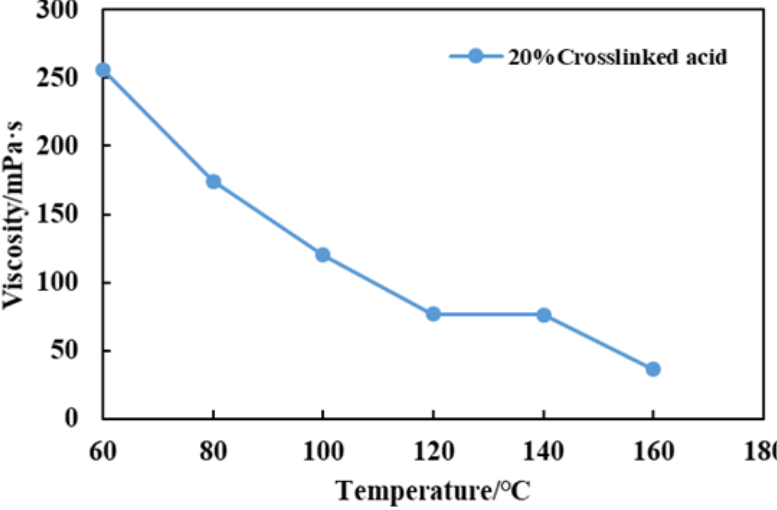
Figure 4. Viscosity – time curve of 20% cross-linked acid at 170 s −1 and 60 °C.